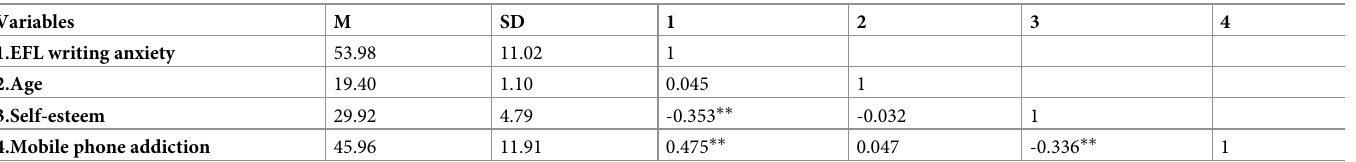
Table 2. Correlations among EFL writing anxiety, self-esteem, and mobile phone addiction. Variables